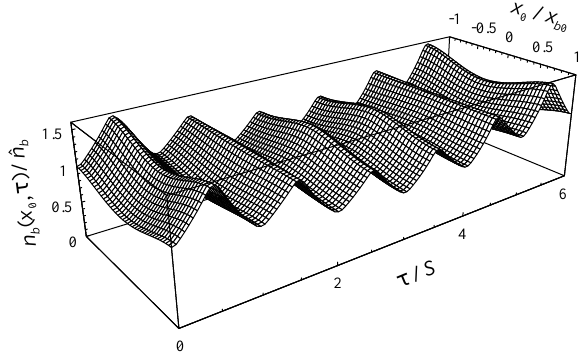
FIG. 6. Plot of density profile n b (cid:1) x 0 , t (cid:2) in Lagrangian variables obtained numerically from Eqs. (82)–(86) for the initial density profile in Eq. (90) and choice of system parameters in Eq. (93).